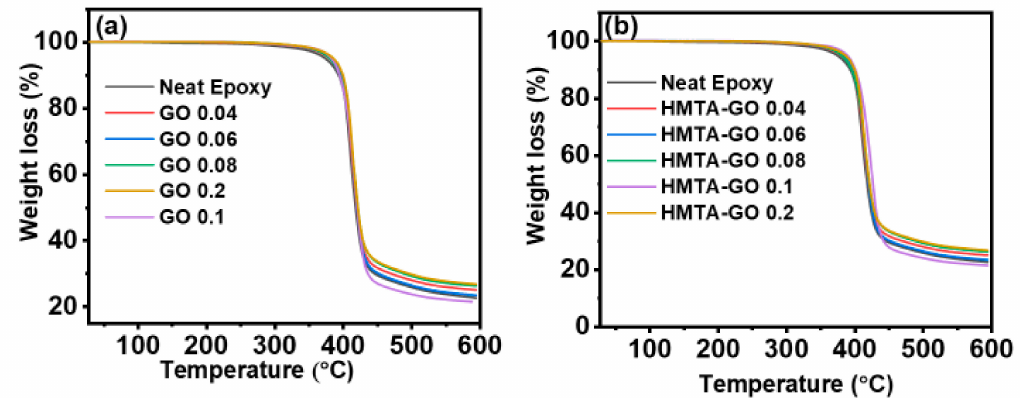
Figure 5. TGA curves for epoxy composites ( a ) GO ( b )